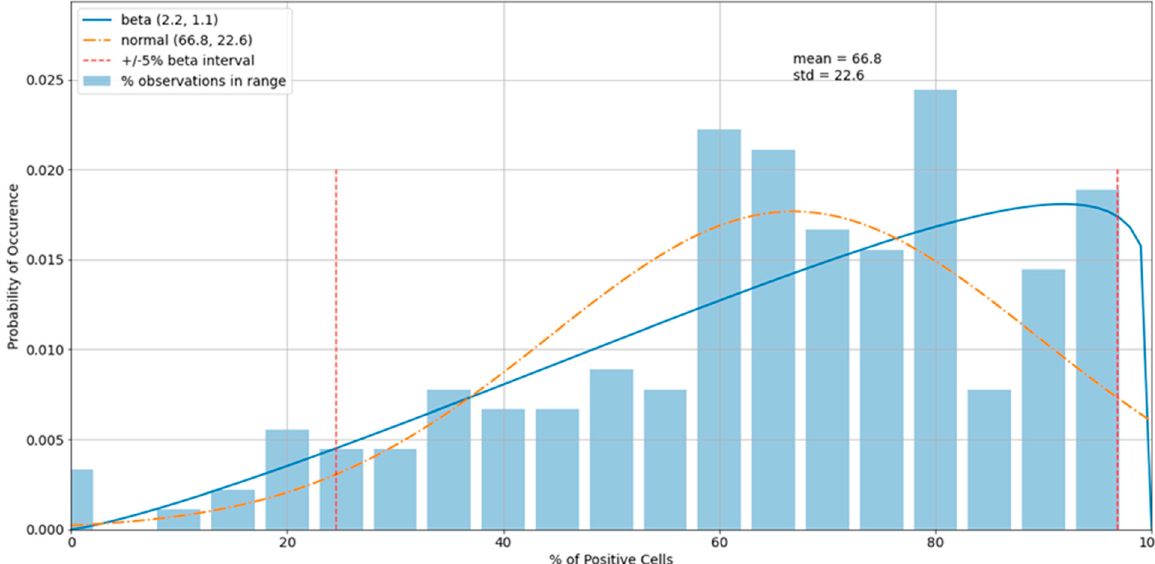
Figure 5. A histogram of the variability of virus control observations with fitted normal and beta distributions.